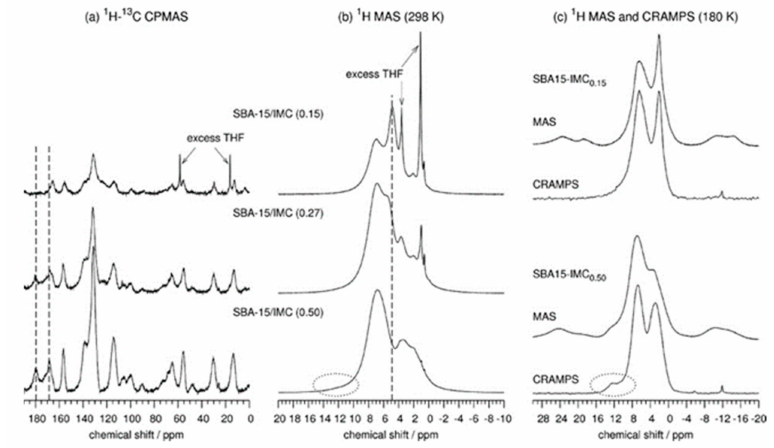
Figure 2. 1 H- 13 C CPMAS ( a ), 1 H MAS ( b ), 1 H MAS, and CRAMPS ( c ) experiments of SBA-15 in which were loaded different amount of indomethacin [6]. (Reprinted with permission from T. Ukmar, T. ˇCendak, M. Mazaj, V. Kauˇciˇc, G. Mali, J. Phys. Chem. C 2012, 116, 2662. Copyright © 2012, American Chemical Society).